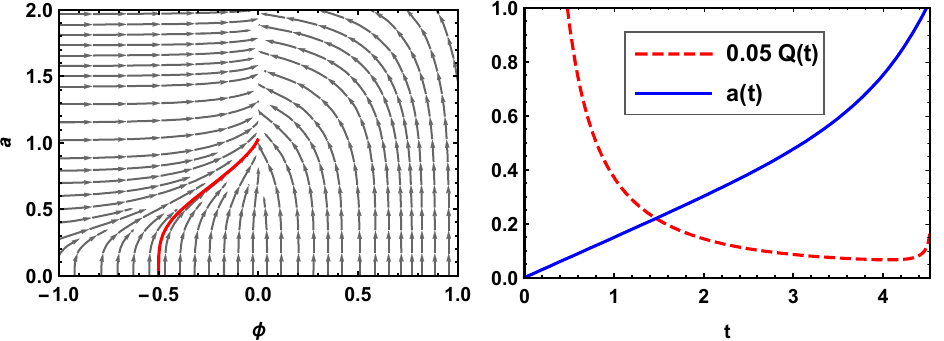
Figure 2. On the left-hand side, we see the phase portrait of system (34), with V 0 = k = γ = 1, and the red line represents the solution for which φ ( 0 ) = − 0.5 and a ( 0 ) = 0.001, as an example. On the right-hand side, we see the behavior of the scale factor (thick line) and the quantum potential (35) (dashed line), both being evaluated for the particular solution highlighted in the phase